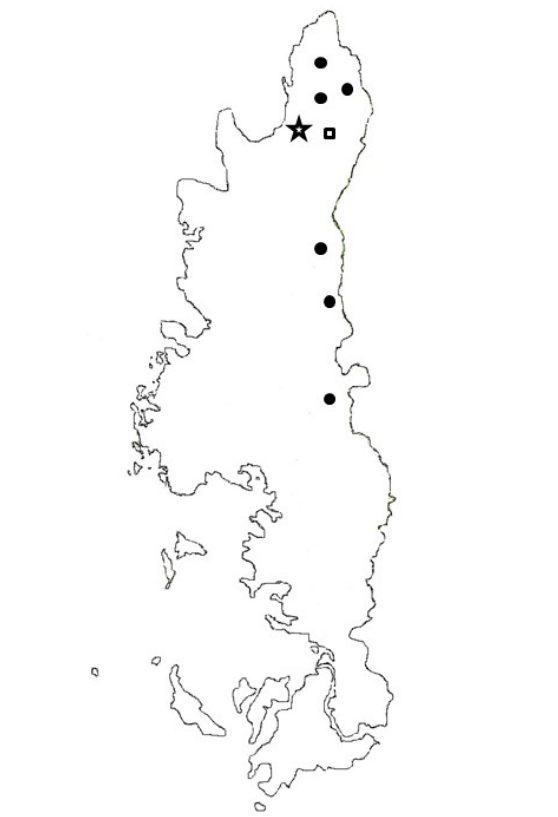
Figure 2. Distribution map of Dinagat Bushy-tailed Cloud Rat Crateromys australis reported by locals (according to Pedregosa- Hospodarsky 2009) (circles), place of finding of the holotype in 1975 (square) and place of observation during our study